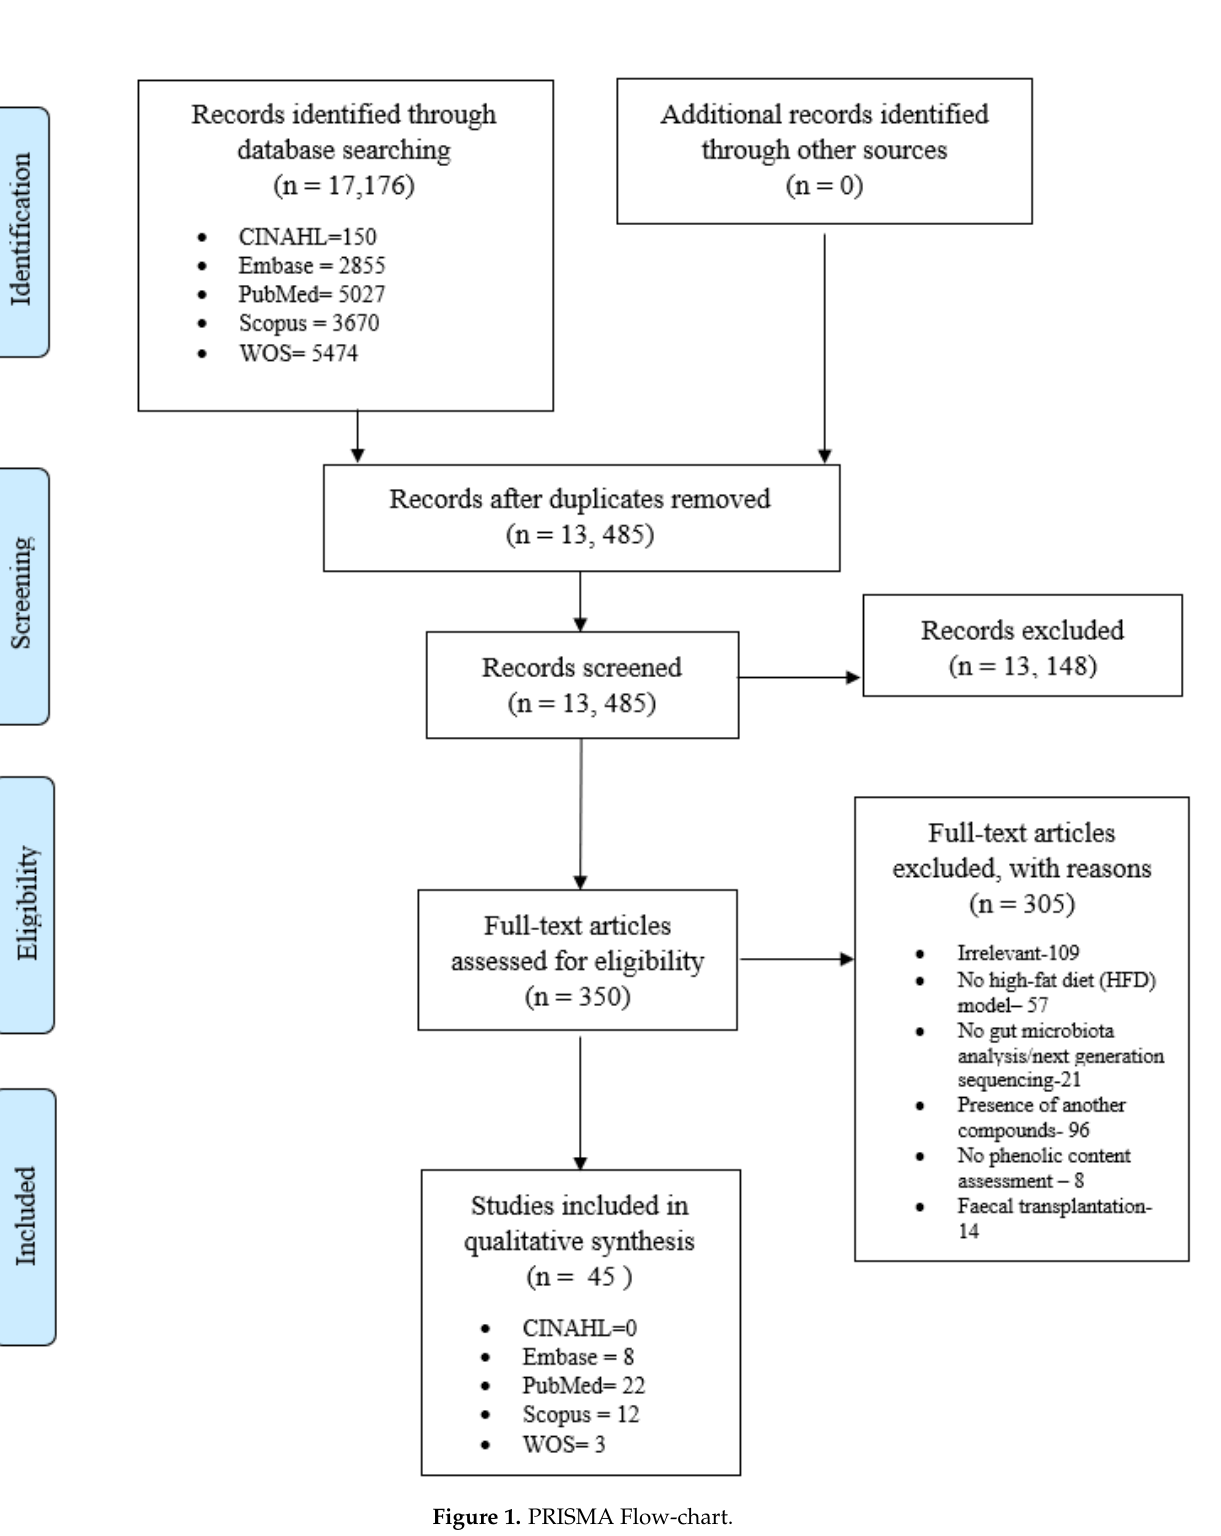
Figure 1. PRISMA Flow-chart.